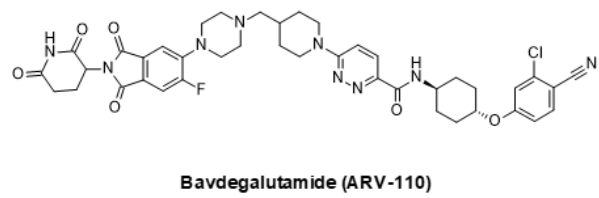
Figure 3. The AR-targeted PROTAC bavdegalutamide